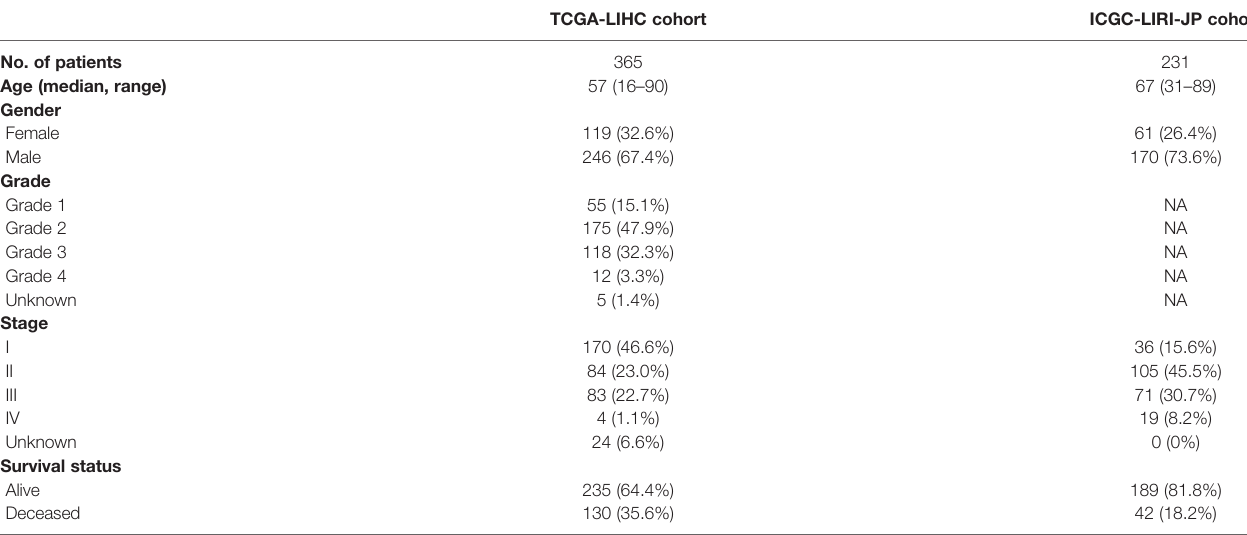
TABLE 1 | Clinical characteristics of the HCC patients used in this